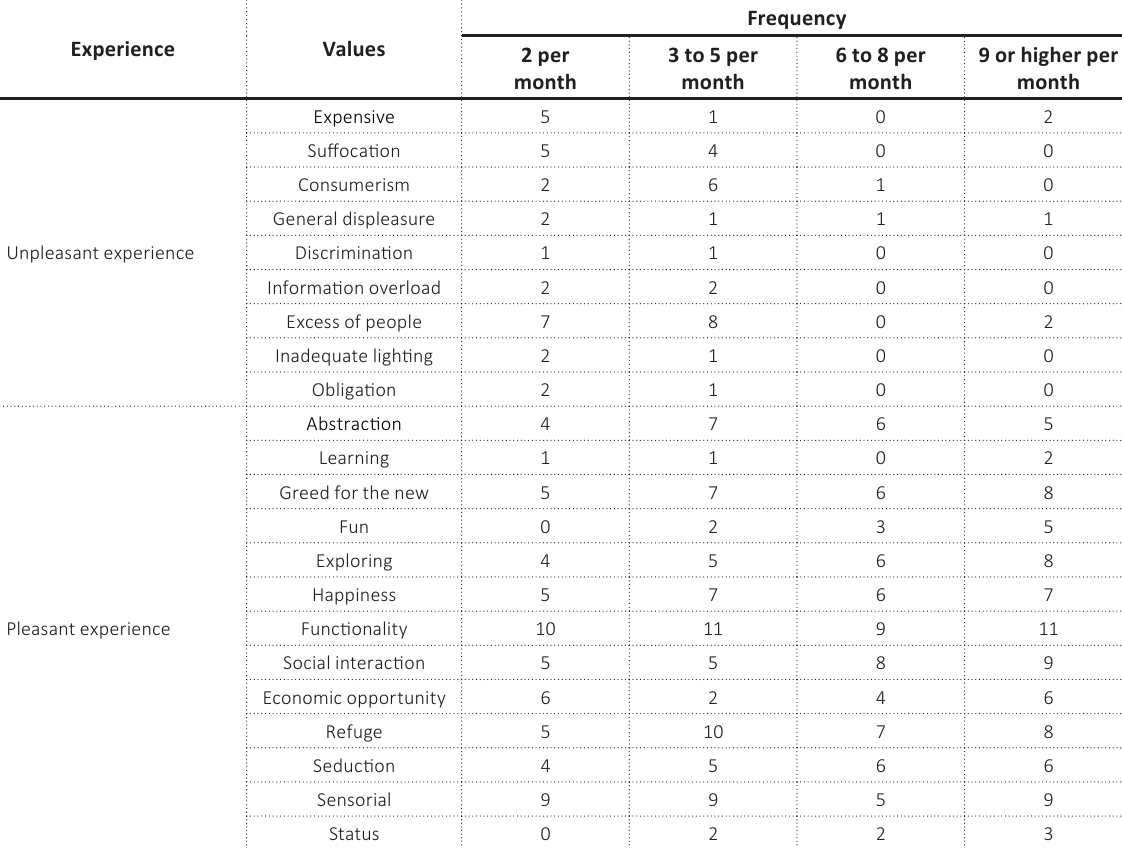
Table 6. Frequency and values (number of